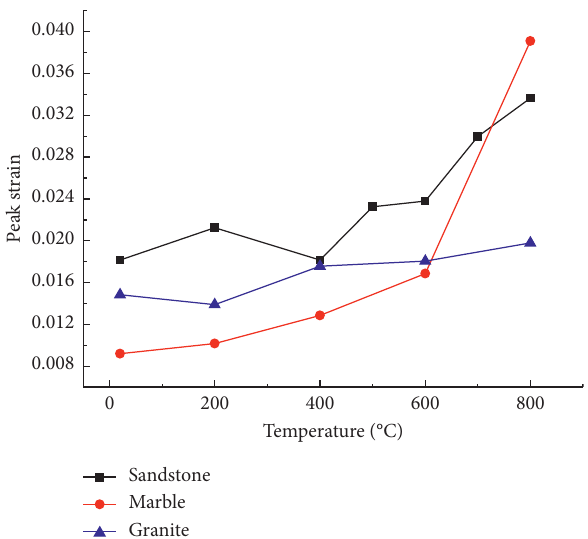
Figure 2: Peak strain for the three rock samples as a function of